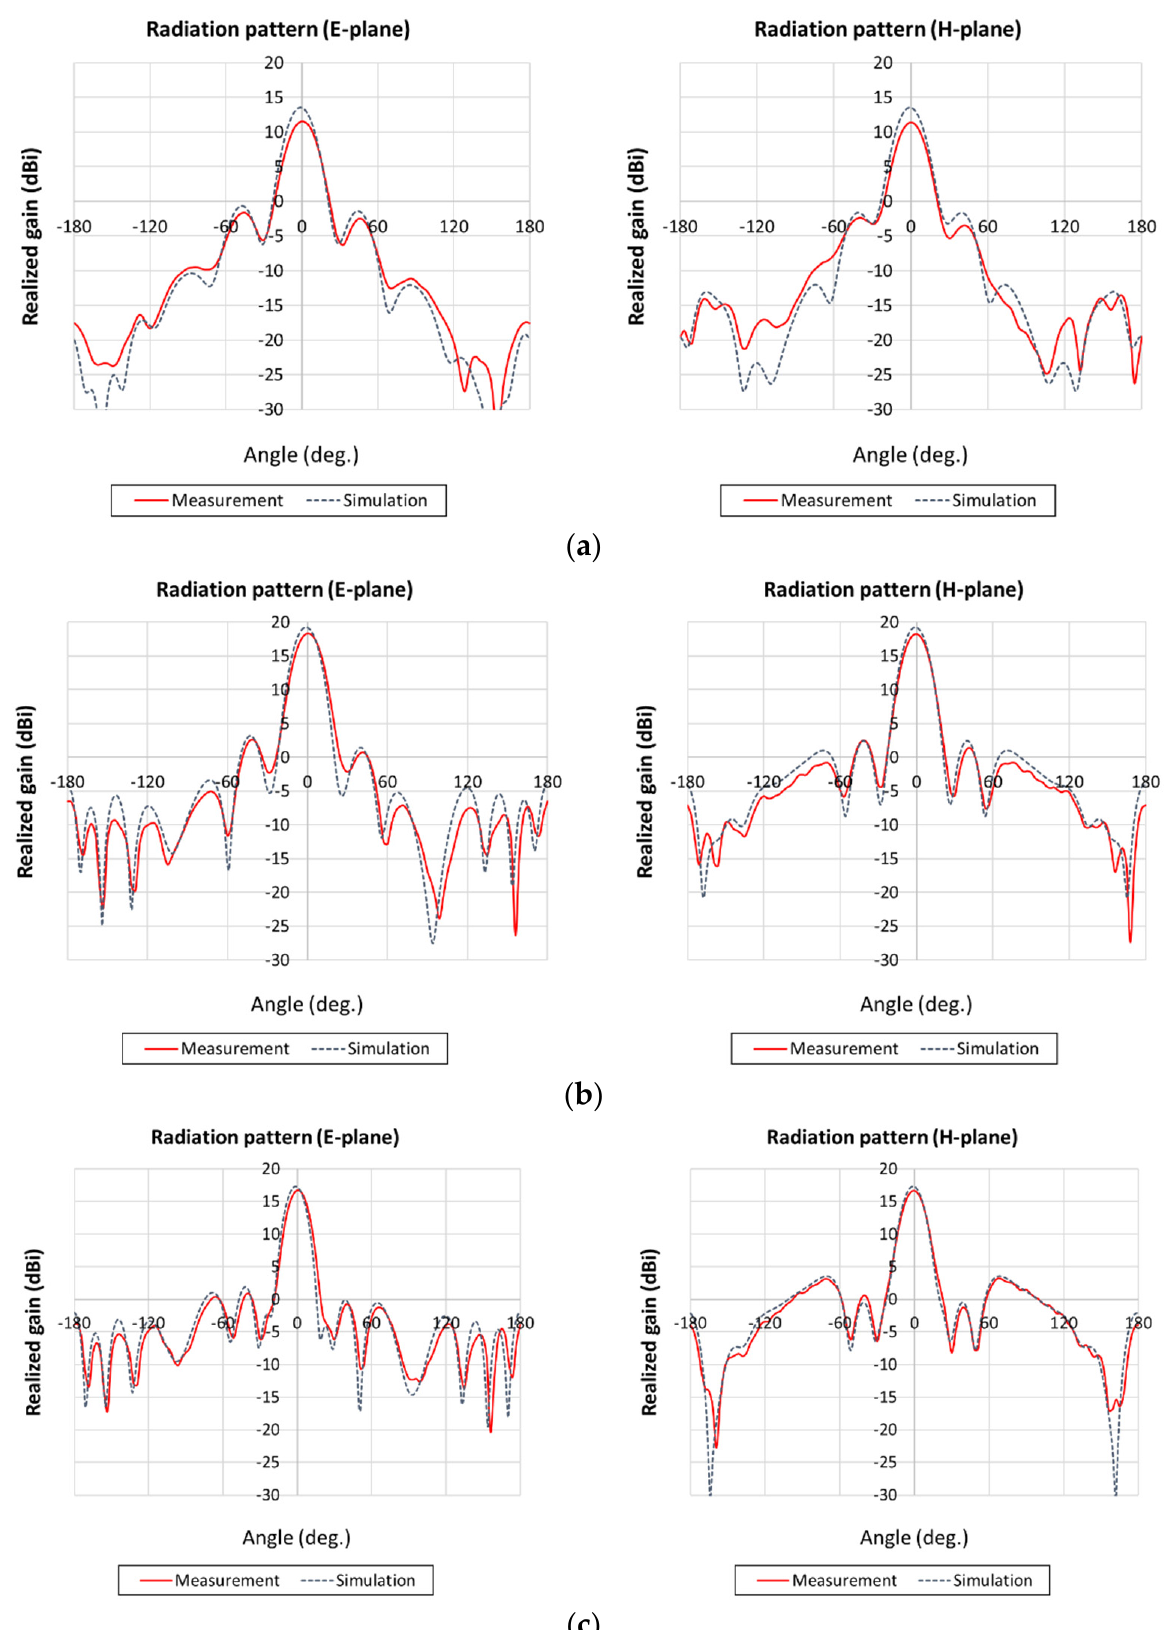
Figure 12. Simulated and measured radiation patterns of the antenna: ( a ) 2.36 GHz, ( b ) 2.41 GHz, ( c ) 2.46 GHz.